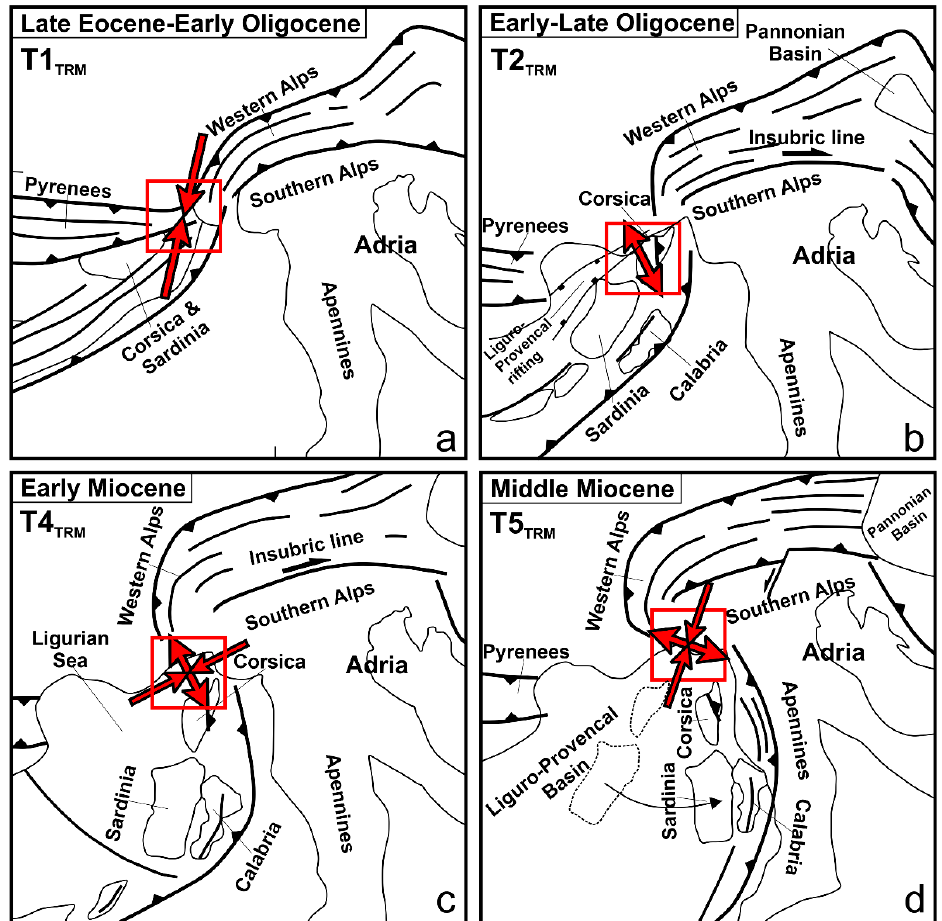
Figure 5. Tectonic setting of the Central-Western Mediterranean (based and modified from [45] ) and paleostress reconstruction of the Ligurian Alps (NW Italy) (red square) since the Late Eocene, considering the 50° counterclockwise rotation that occurred in Early–Middle Miocene [32,69] . ( a ) T1 TRM (restored) ( b ) T2 TRM (restored), ( c ) T4 TRM , and ( d ) T5 TRM . Explanation: σ 1 and σ 3 axes are shown with convergent and divergent arrows, respectively.